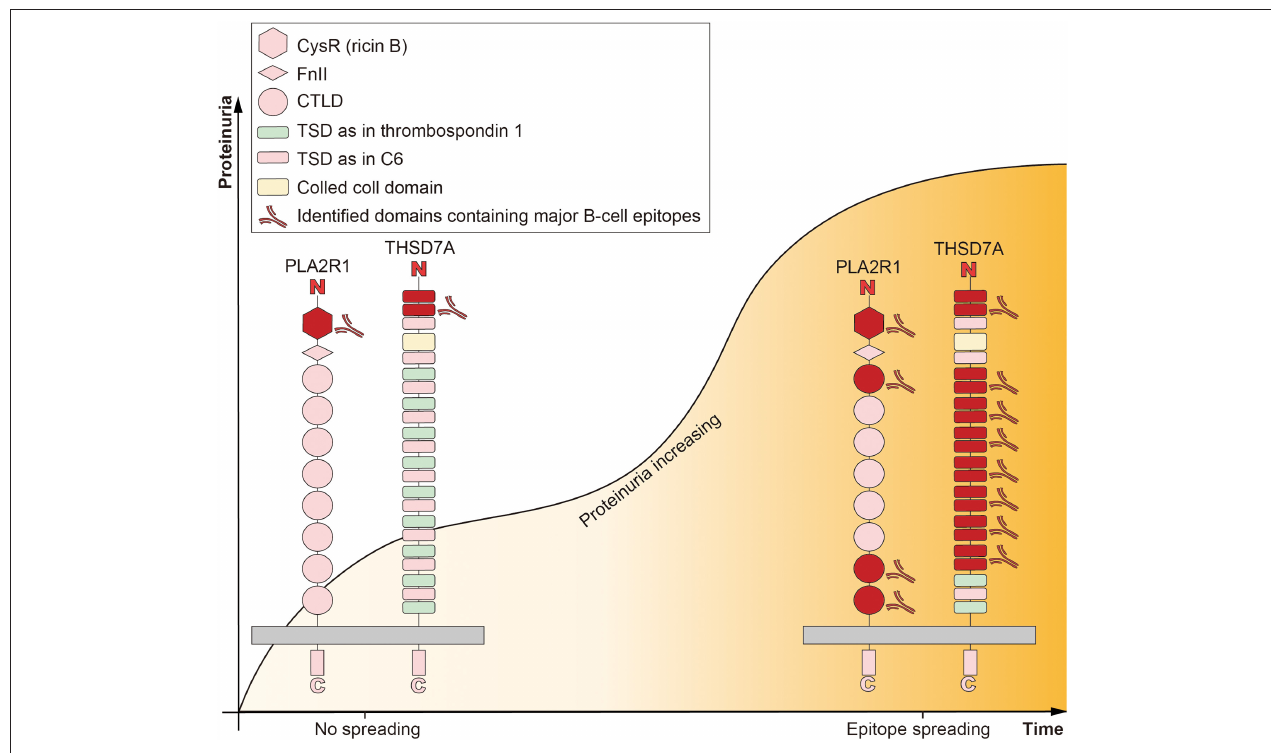
FIGURE 1 | Epitope spreading accompanied with diseases progression in idiopathic membranous nephropathy. The extracellular part of M-type receptor for secretory phospholipase A2 (PLA2R1) is composed of N-terminal cysteine-rich (CysR, or ricin B) domain, a single fibronectin type II (FnII) domain, and 8 C-type lectin-like domains (CTLDs). The four identified domains containing major B-cell epitopes are CysR, CTLD1, CTLD7, and CTLD8. CysR is the predominant target of autoimmunity. The extracellular part of thrombospondin type-1 domain-containing 7A (THSD7A) is composed of a colled coll domain and 21 thrombospondin type 1 domains (TSDs). These TSDs show high structural homology either to the TSDs of thrombospondin 1 or complement component 6 (C6). The predominant target of autoimmunity is exists in the N-terminal region. Epitope spreading is defined as the diversification of epitope specificity from the initial focused, dominant epitope-specific immune response, to subdominant and/or cryptic epitopes, which accompanied by maturation of the immune response and progression of the disease (proteinuria